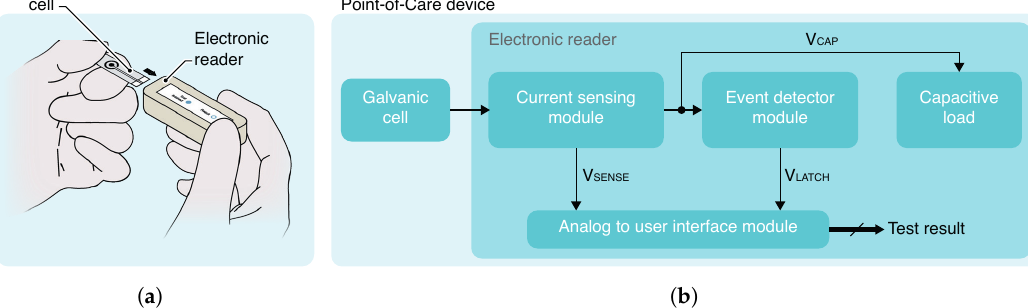
Figure 1. ( a ) Scheme of the application consisting of a disposable test strip and a reusable electronic reader. ( b ) Block diagram of the proposed self-powered point-of-care